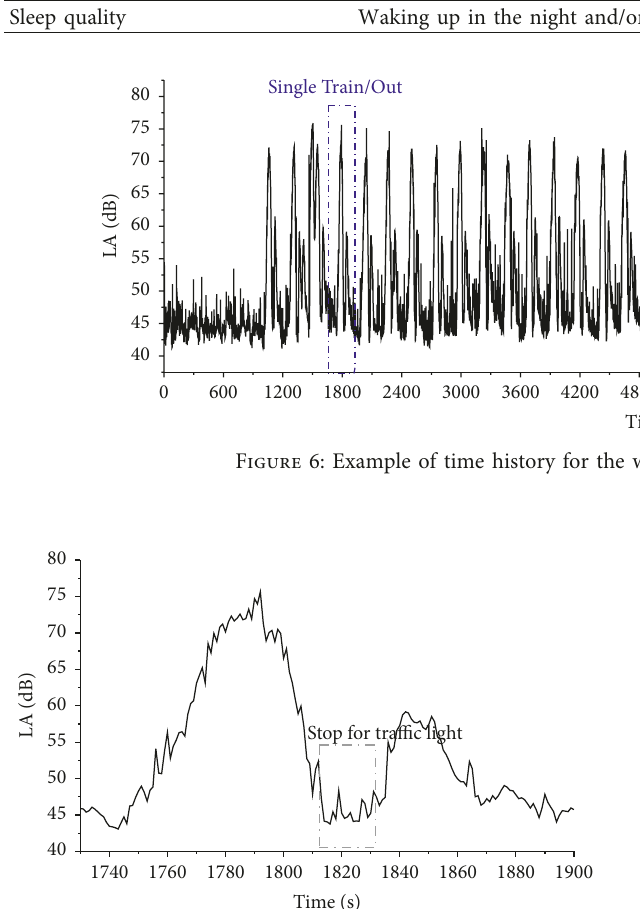
Figure 8: Example of selection of measuring time interval for a whole train passage (coming